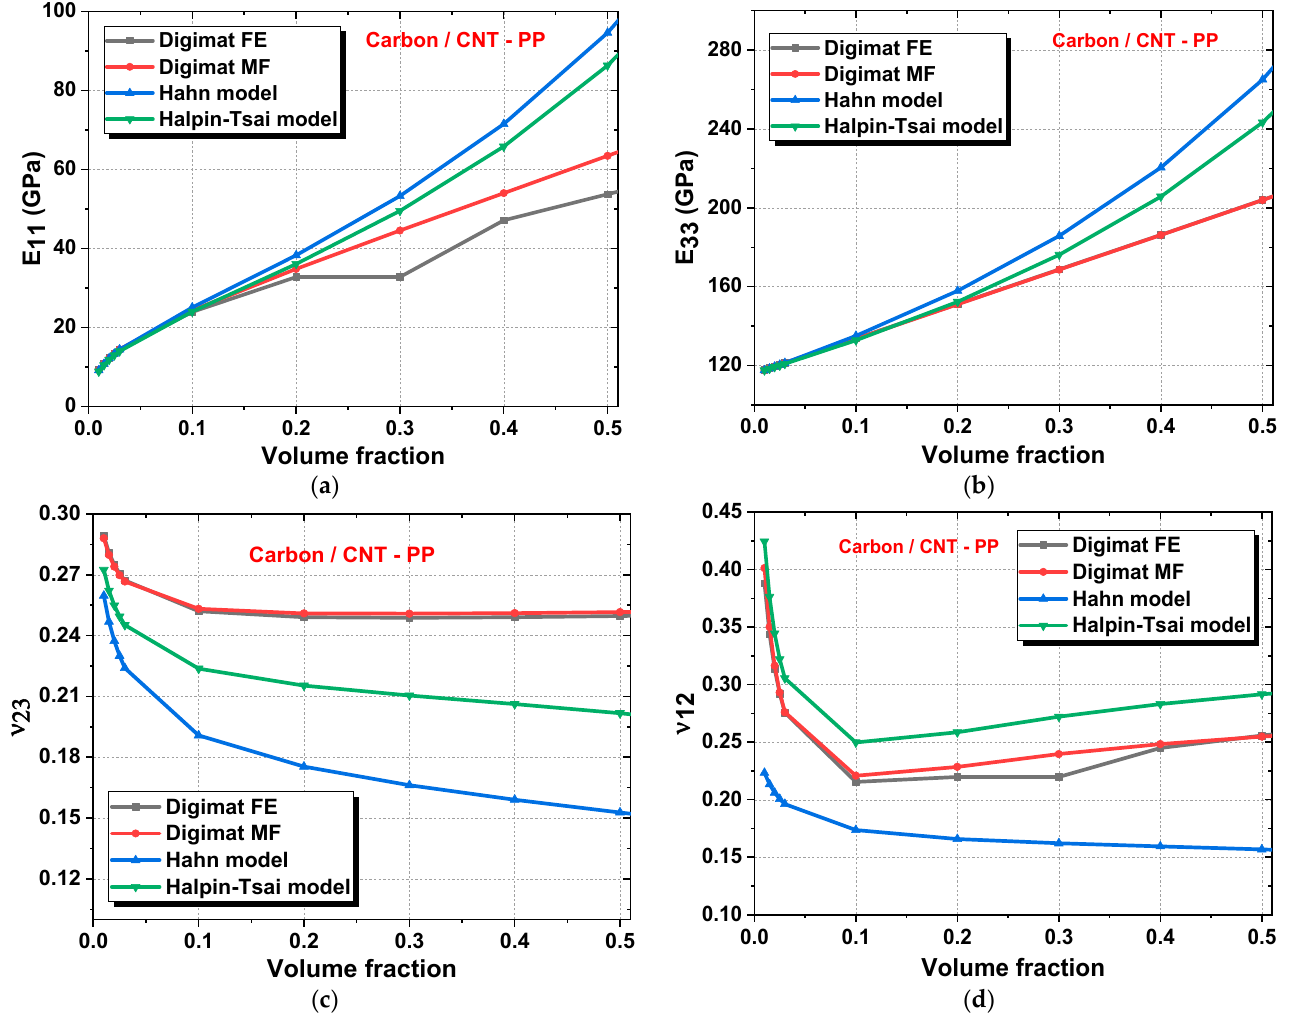
Figure 8. The transversely elastic moduli of CNT-PP matrix reinforced by carbon-(T-300) aligned fiber, using numerical and analytical methods: ( a ) E 11 axial Young’s modulus; ( b ) E 22 in-plane Young’s modulus; ( c ) ν 23 in-plane Poisson’s ratio; and ( d ) ν 12 axial Poisson’s ratio. The longitudinal Young’s modulus increases as a function of CNT and GNP